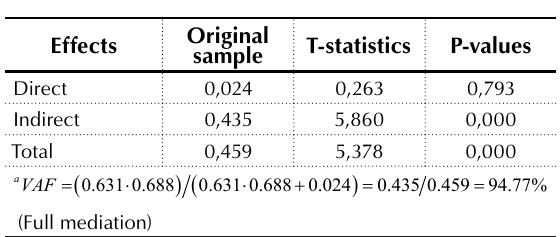
Table 2. Effects of destination image on intention loyalty